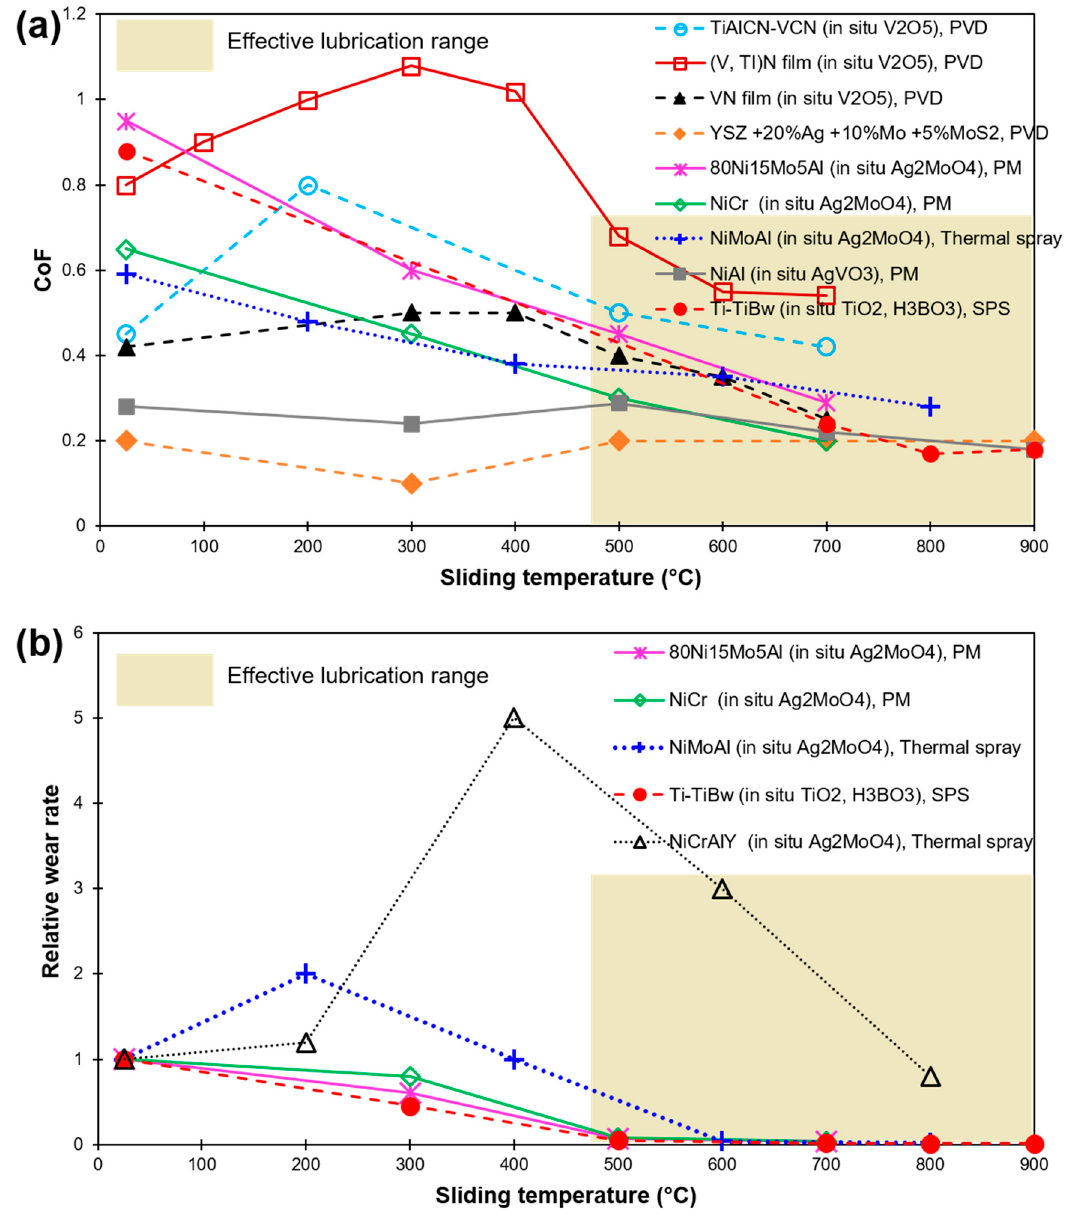
Figure 13. HT sliding results of oxide-based lubrication and coatings as found in recent literature ( a ) CoF; ( b ) Relative wear rate (in relation to their corresponding RT wear). Values are labelled as per oxide formation (in situ), matrix material, and fabrication method [4,13,118,120,123–127].